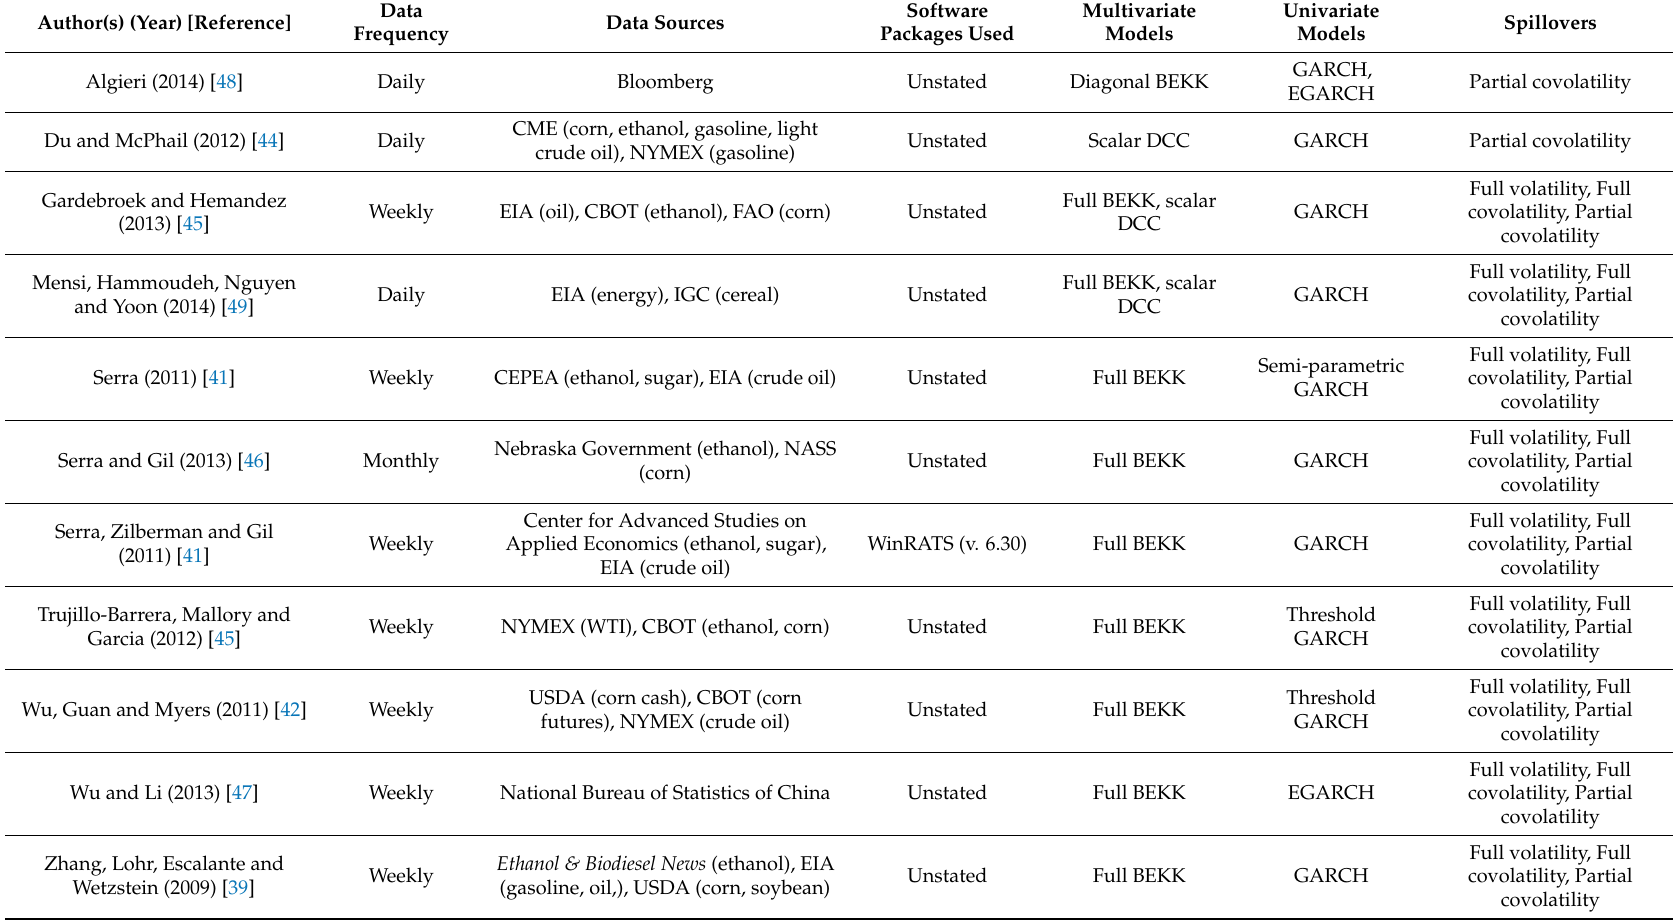
Table 2. Summary of Literature on Volatility between Energy and Agricultural Markets using BEKK and